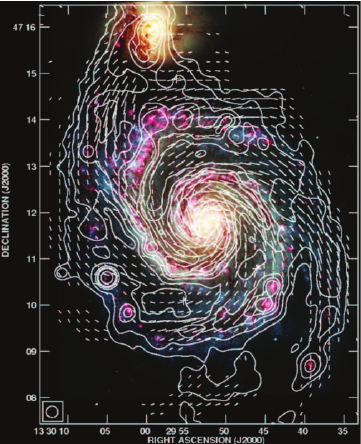
Figure 11. Total intensity contours of the λ 6cm radio contin- uum emission from the face-on spiral galaxy M51 observed with the VLA and the E ff elsberg 100m radio telescope. The back- ground is an optical image from the HST. The small bars show the polarization half-vectors rotated by 90 ◦ to trace the orienta- (cid:3) B tion of ⊥ , with no correction for Faraday rotation [41].